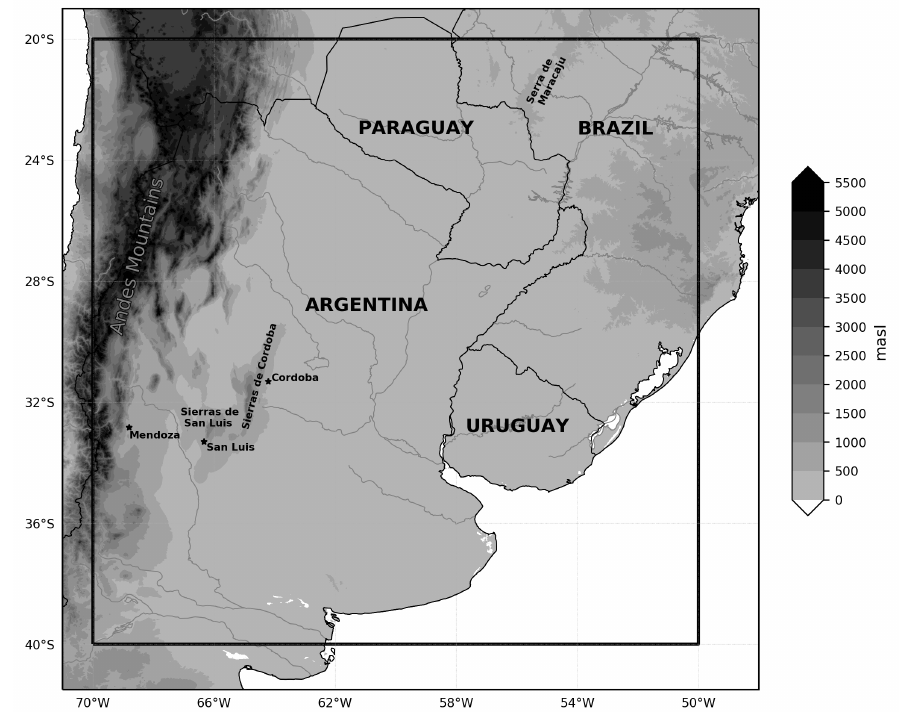
Figure 1. Southeastern South America (SESA) (black box); countries and cities mentioned in this work; relevant elevations and topography